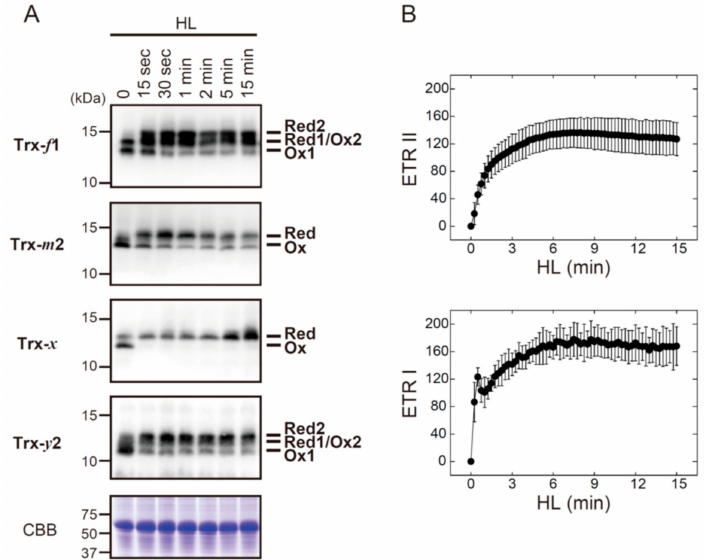
Figure 2. The in vivo redox responses of Trx isoforms and their relationship to photosynthetic electron transport rates in Arabidopsis . ( A ) Dark-adapted plants were placed under HL conditions (650–700 µ mol photons m − 2 s − 1 ) for the indicated time period. The redox states of Trx- f 1, Trx- m 2, Trx- x , and Trx- y 2 were then determined as previously described [19]. As a loading control, Rubisco large subunit was stained with Coomassie Brilliant Blue R-250 (CBB). Red, reduced form; Ox, oxidized form. ( B ) Dark-adapted plants were irradiated by HL, and relative ETR II and ETR I were sequentially measured. Values represent the mean ± SD ( n = 5). HL: High light; ETR II: Electron transport rates of PSII; ETR I: Electron transport rates of